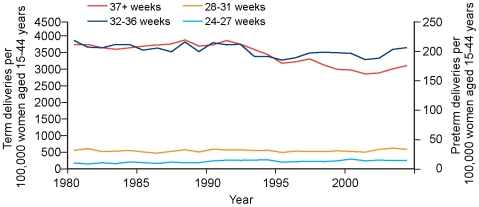
Spontaneous births per 100,000 women of reproductive age, 1980–2004.